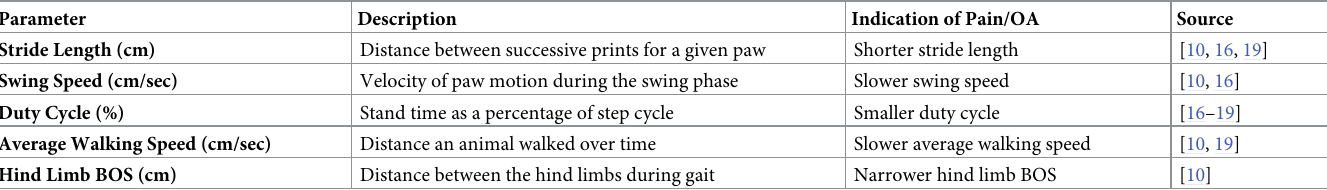
Table 1. Parameters utilized to assess gait in statistical analyses. All four limbs were individually assessed (i.e., Right front limb, left hind